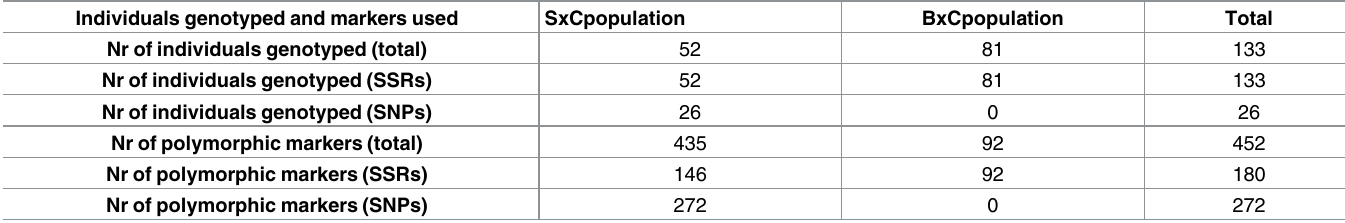
Number of individualsfrom Castanea sativa (cultivar Aveleira) x C . crenata2 (SxC) and C . sativa (cultivar Ba´ria) x C . crenata1 (BC) crosses and number of polymorphic markers (SSRs and SNPs) used for genetic map